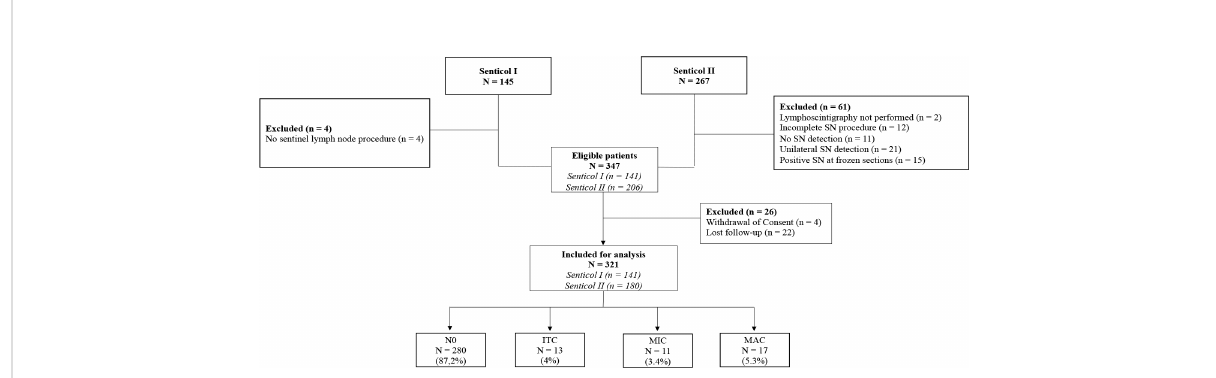
FIGURE 1 Flowchart of Senticol 1 and 2 patients inclusion. SN, sentinel node; N0, negative node; ITC, isolated tumour cells; MIC, micrometastasis; MAC,